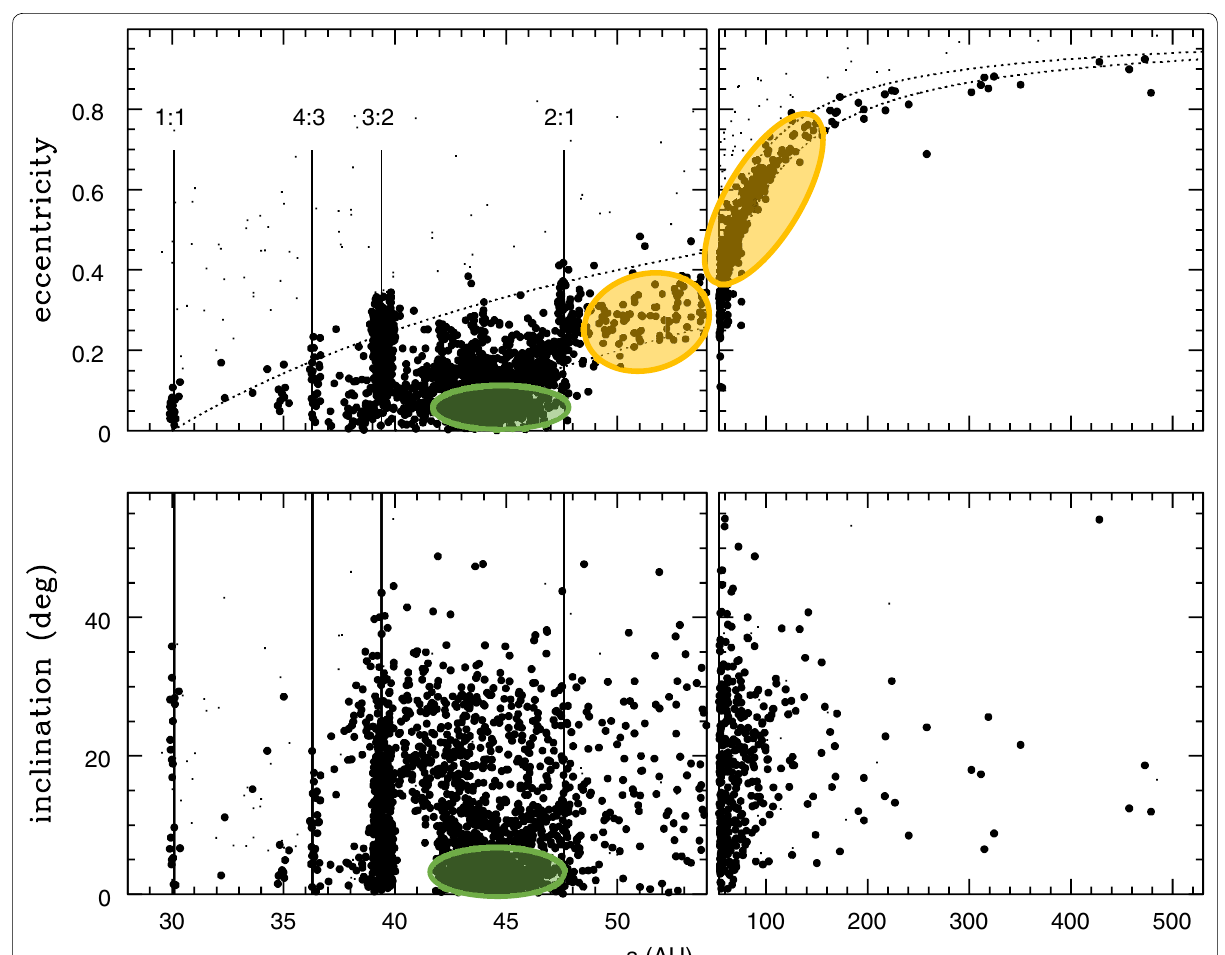
Fig. 2 The orbital distribution of known Kuiper belt objects. The vertical lines mark the locations of some prominent mean motion resonances of Neptune. The cold classicals and the scattered disk objects are indicated with green and orange ovals, respectively. (Based on data from the Minor Planet Center, 6 June